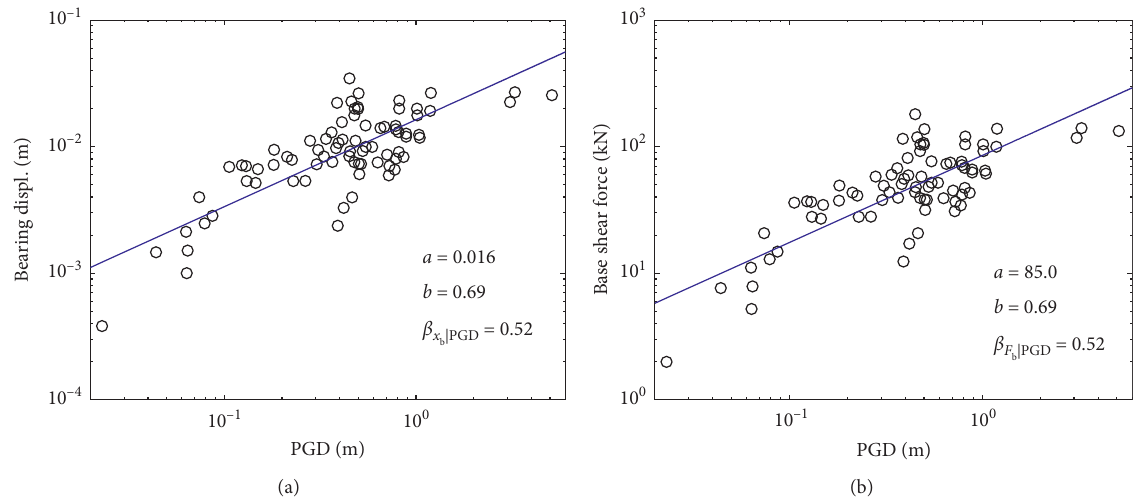
Figure 7: Linear fit demand model with PGD: (a) bearing displacement; (b) base shear